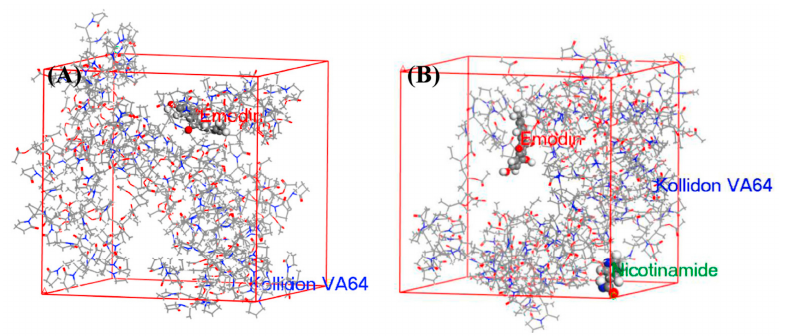
Figure 8. Snapshots of the final frame (at 100 ns) ( A ) Emodin and Kollidon ® VA 64 and ( B ) Emodin, Kollidon ® VA 64 and nicotinamide, of the molecular dynamics simulation. Adapted with permis- sion from Ref. [132]. 2023,